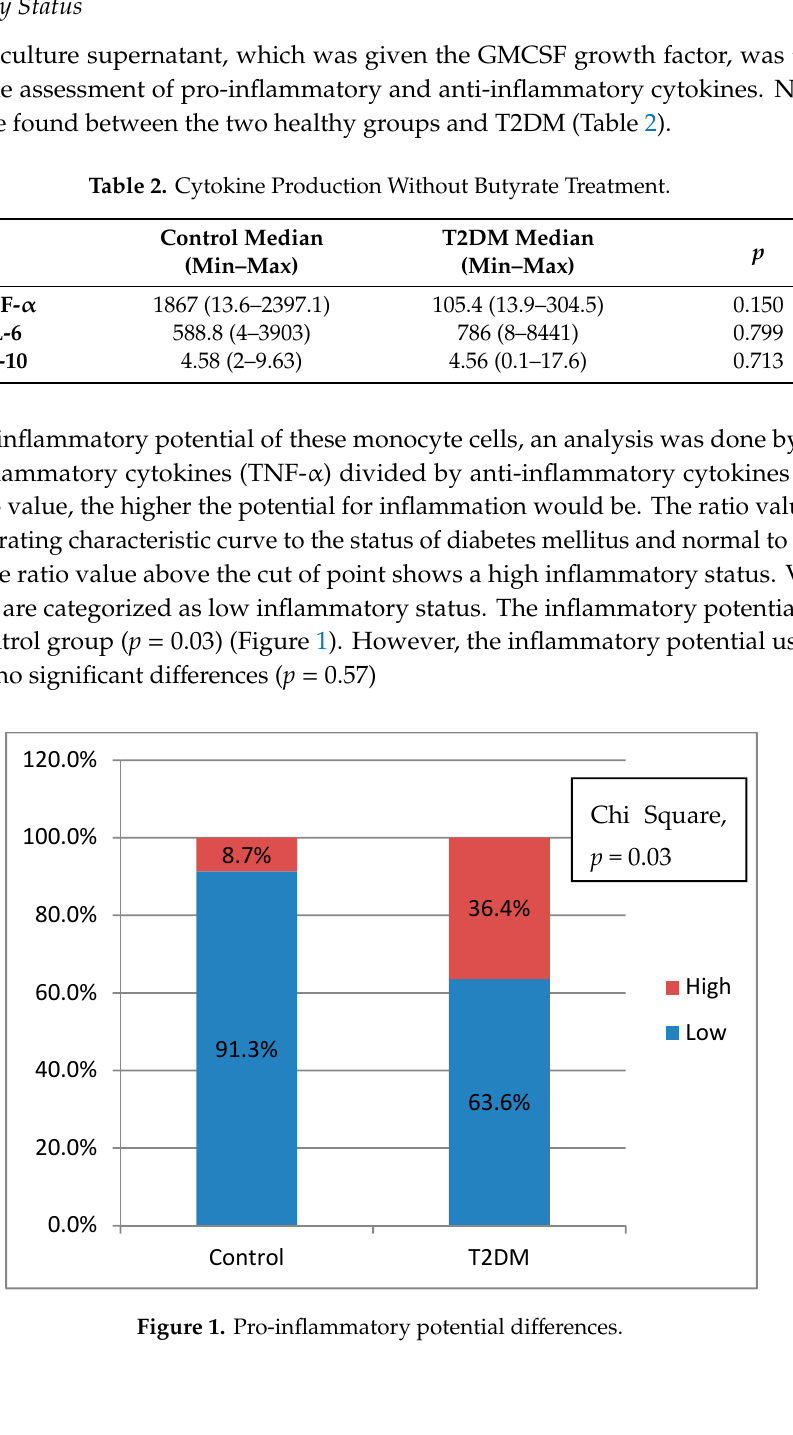
Table 3. Cytokine production with butyrate treatment. Control Median (Min– Max)